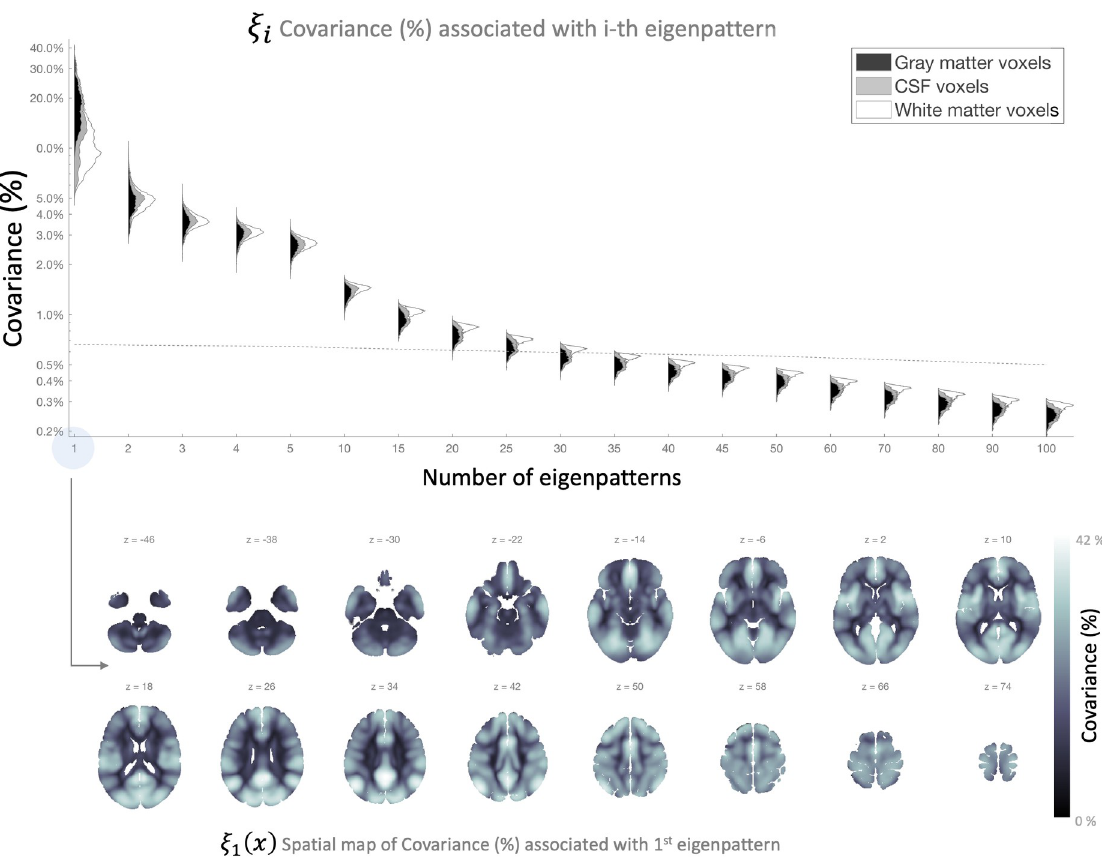
Fig 4. Percentage of total covariance associated with each fc-MVPA eigenpattern. Top : histogram of ξ k ( x )|1 � i � 100values, percentage of the total covariance explained by each of the first 100 eigenpatterns. Histograms are further broken down by the most likely tissue class (gray matter in black, CSF areas in grey, and white matter in white) at each individual voxel as defined by SPM’s tissue probability map templates. Bottom : spatial map ξ 1 ( x ) showing the proportion of the total intersubject covariance explained by each voxel’s first eigenpattern (a measure of the overall intersubject homogeneity in functional connectivity patterns at each voxel; see text for details).